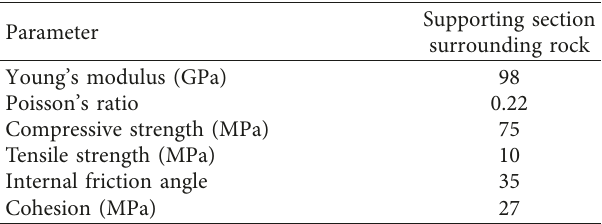
Table 3: Rock mechanical parameters.